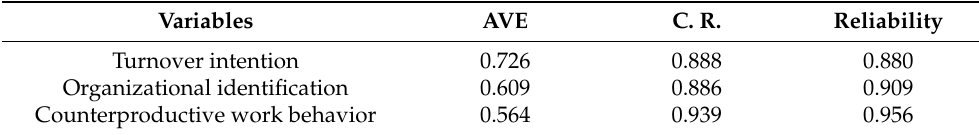
Table 2. Convergent validity analysis results.